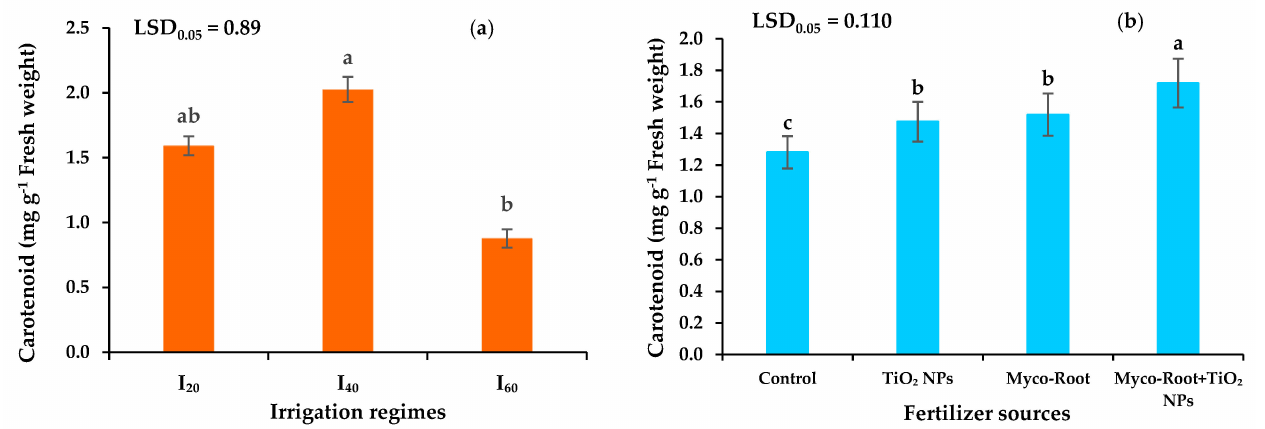
Figure 4. The effects of different irrigation regimes ( a ) and fertilizer sources ( b ) on the carotenoid concentration of peppermint. I 20 , I 40 , and I 60 indicating well-watered, mild, and severe drought stress, respectively. Different letters indicate significant differences at the 5% level according to LSD’s test.